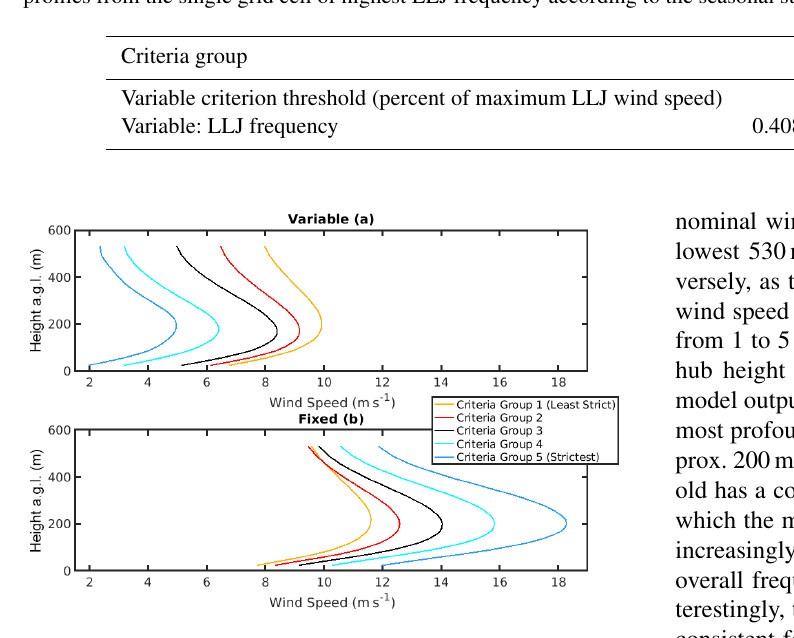
Figure 7. Temporal mean LLJ wind speed profiles extracted by each criterion – variable (a) and fixed (b) – colored by criteria group (criterion utilized for seasonal analysis is shown in red as part of Criteria Group 2). Temporal mean wind speed profiles per group are calculated from LLJ events as described in frequencies in Ta- bles 3 and